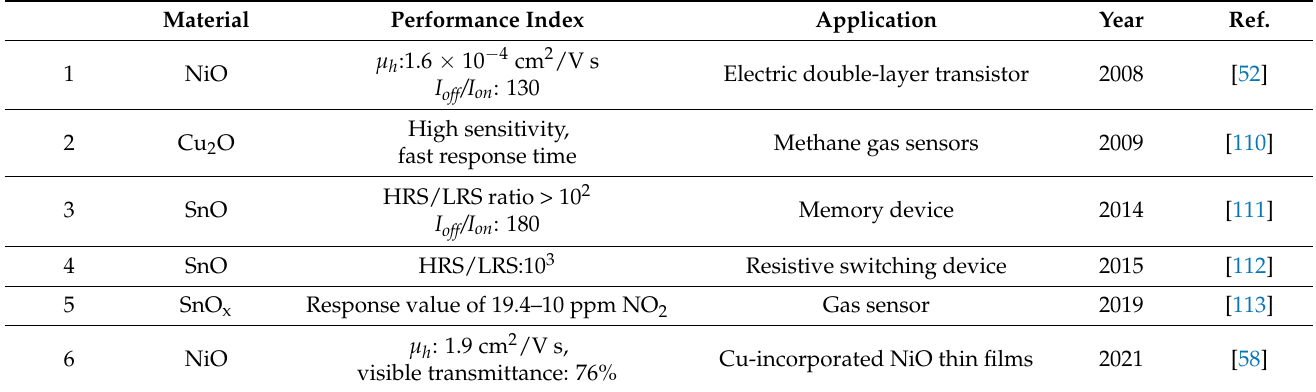
Table 4. p-Type oxide Thin-Film transistors and their potential industrial